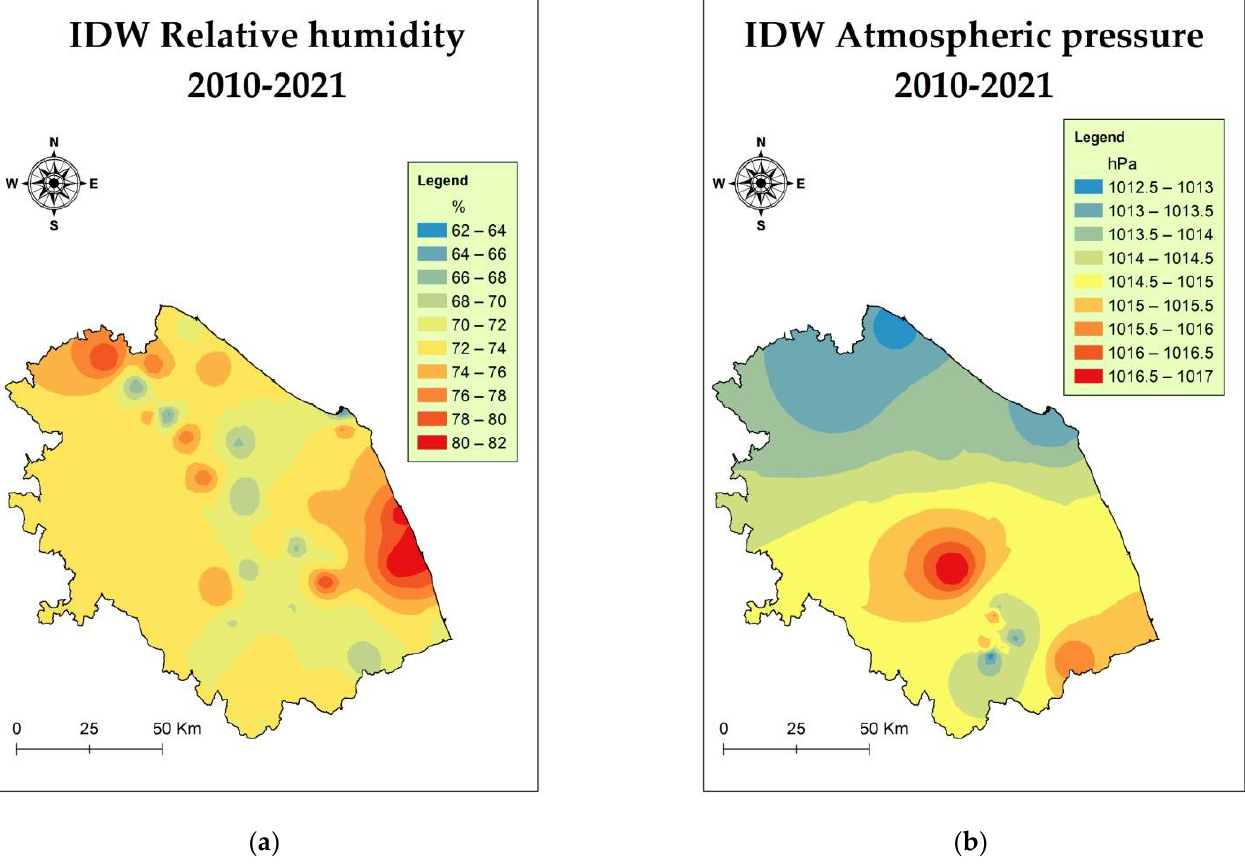
Figure 2. Interpolation example performed with the IDW method and annual average data from 2010 to 2021: ( a )Relative humidity( b )Atmospheric pressure.